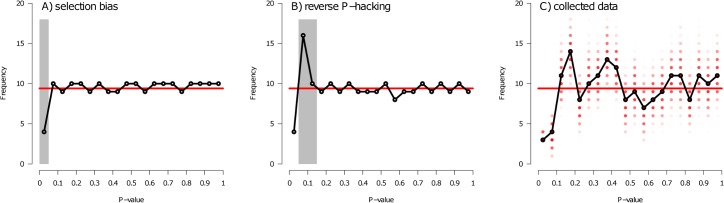
Frequency distribution of numerical P-values (P-curve).Two hypothetical examples of P-curves show the expected distribution if (a) selection bias is present or (b) certain types of reverse P-hacking occur (see [12]). Data collected from articles testing the effect of confounding variables between treatment(s) and control groups are shown in (c). In (c), darker red points represent a higher frequency of P-values/bin among the randomised datasets. The horizontal red line denotes the theoretical even distribution across 20 bins (188 articles in 20 bins = 9.4 articles/bin). The grey rectangles emphasize intervals of interest in the two hypothetical scenarios. We only used P-values presented to at least two decimal places. The full data file of the 1,805 articles consulted and the 250 from which data were extracted and the R scripts used for the analysis and to generate the figures are available at https://figshare.com/s/f3bb7dfefdaa8976d3a1 or https://osf.io/au7yc/.